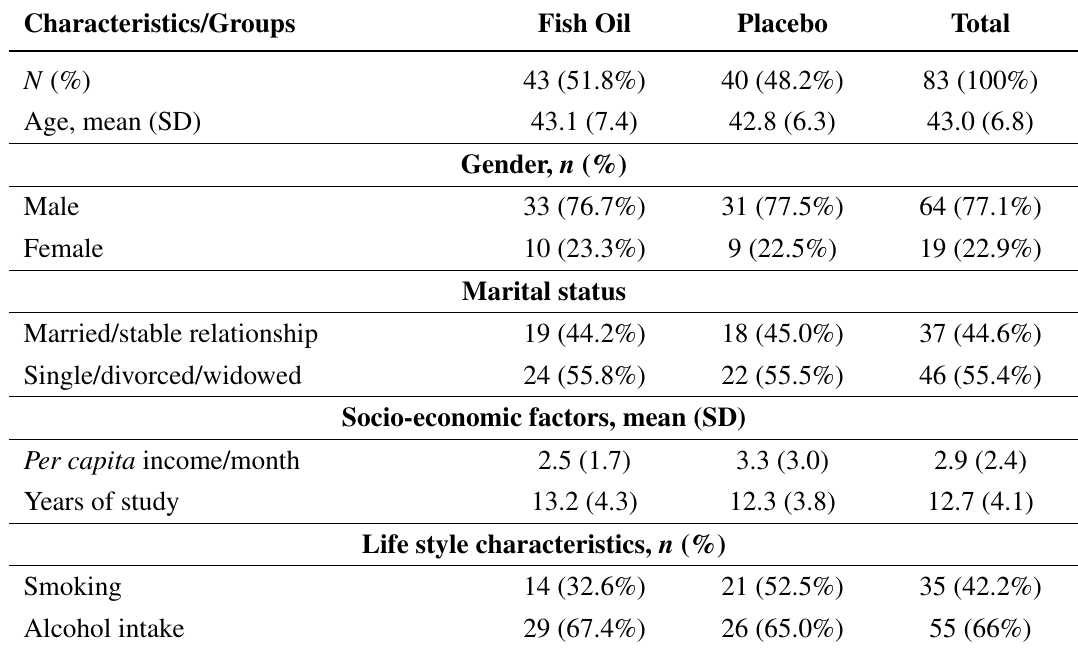
Table 1. Characteristics of the